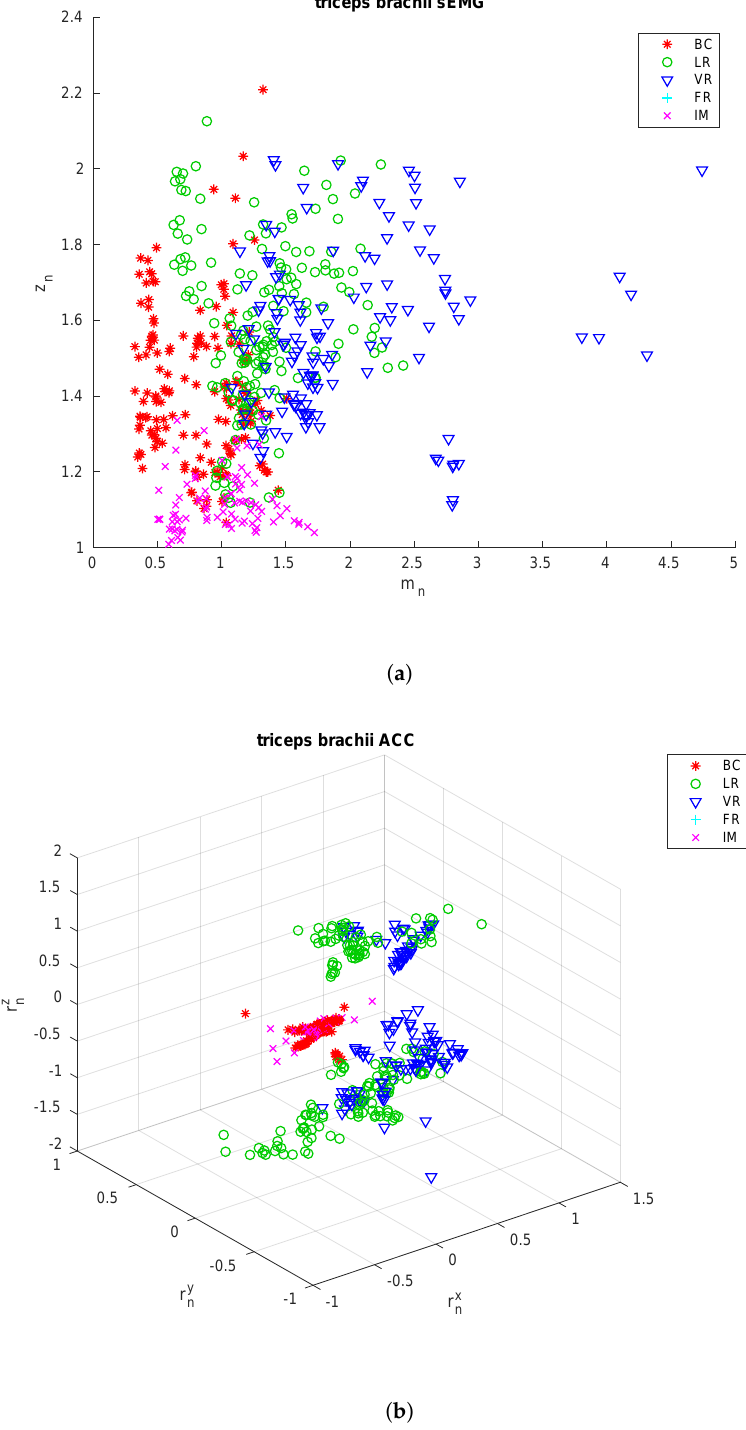
Figure 5. Triceps brachii signals. Extracted from the sEMG signal ( a ) and the acceleration signals ( b ) from the sensors applied to the deltoideus medius of all the subjects included in the training and testing sets. Due to some problems inherent in the sEMG measurements, including the separability and reproducibility of measurements, the size of discriminable arm exercices set was limited to 4 classes, excluding the frontal raises exercise from the rest of the